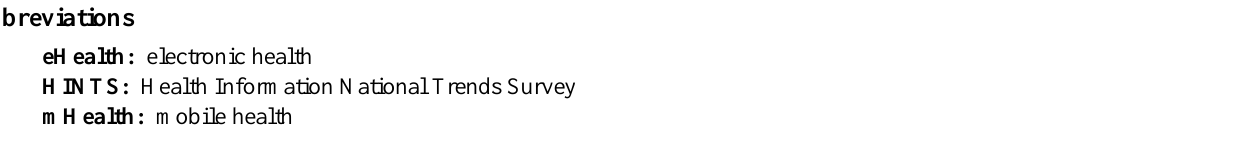
HINTS: Health Information National Trends